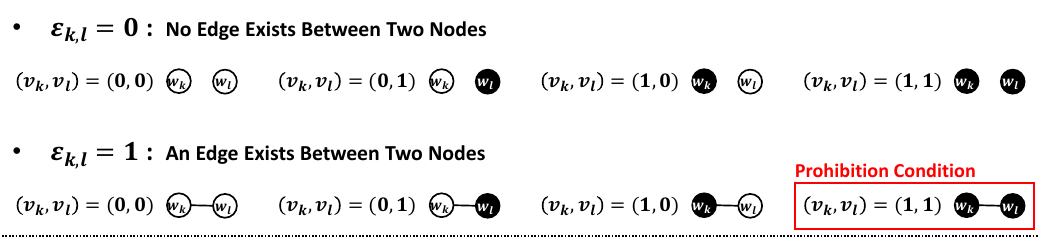
Figure 4. Number of all possible cases between 2